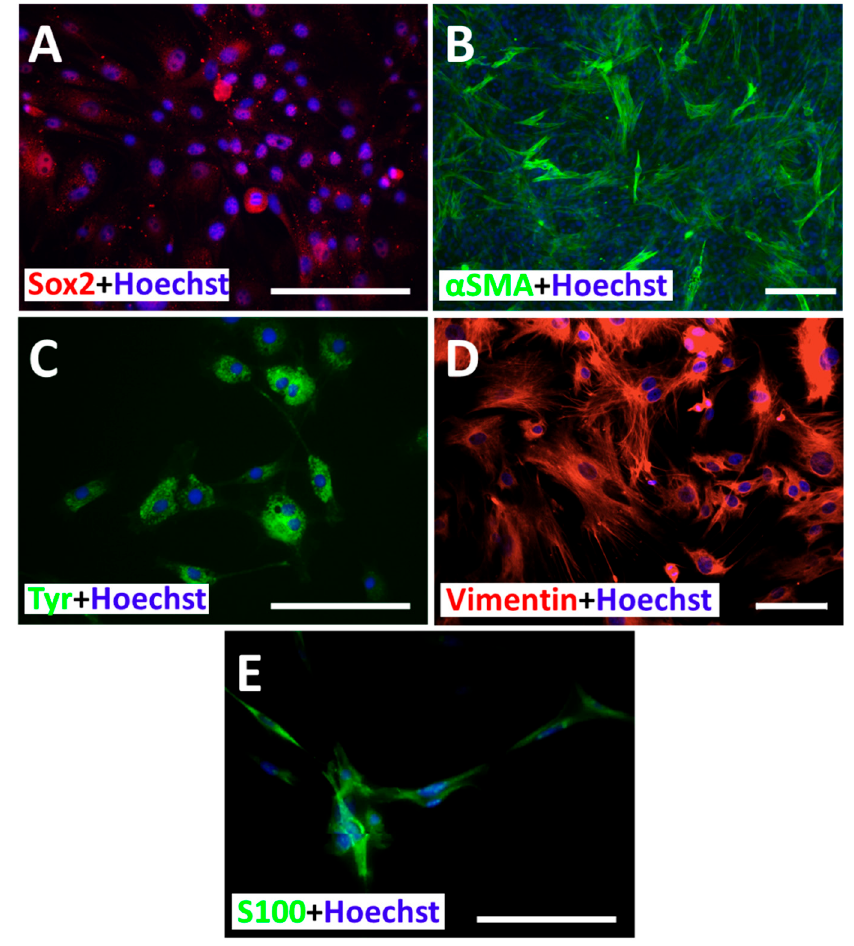
Figure 3. Horse hair follicle melanocytes in culture with immunostaining. Immunofluorescent staining of horse HM with antibodies against ( A ) Sox2, ( B ) α SMA, ( C ) Tyrosinase, ( D ) Vimentin and ( E ) S100ß. Nuclear counterstaining was performed using Hoechst 33342. Magnification: ( A , C , D ) 40×, ( B ) 20×; scale bar: 100 µm.